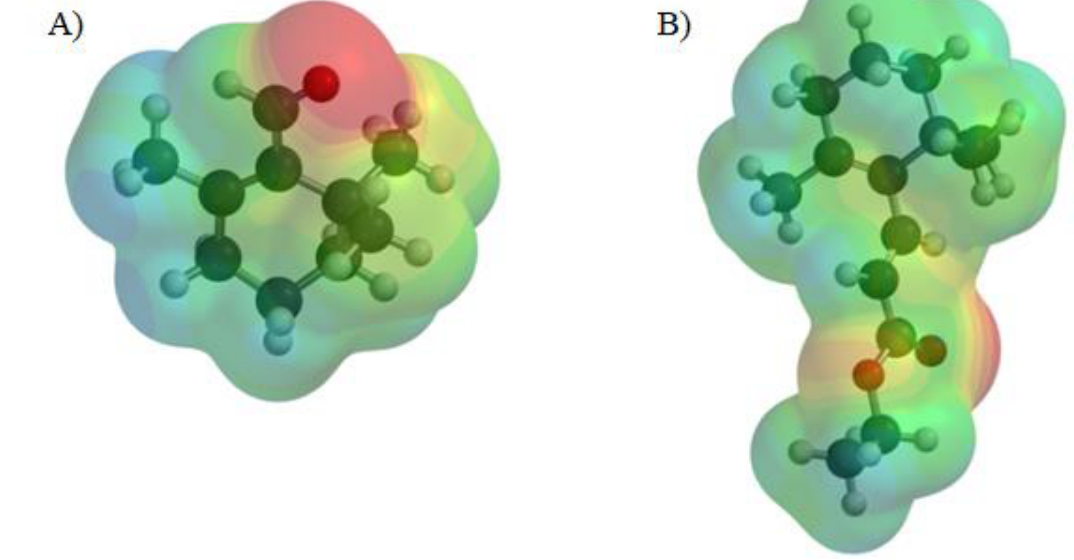
Figure 9. Electrostatic potential maps for β-cyclocitral ( A ) and TMPE ( B ) in aqueous solution. The blue color represents the positive region and the red color represents the negative region. The images were obtained using SPARTAN software.